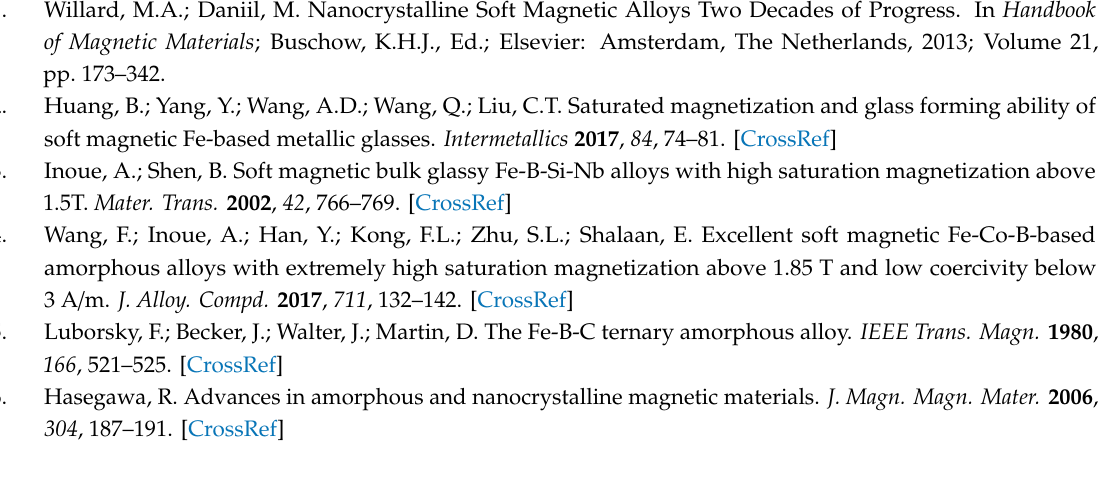
Figure 7. ( a ) The magnitude of core loss ( P s ) at different magnetic fields (constant frequency of 50 Hz). ( b ) The magnitude of core loss at different frequencies (constant magnetic field of 0.3 T).